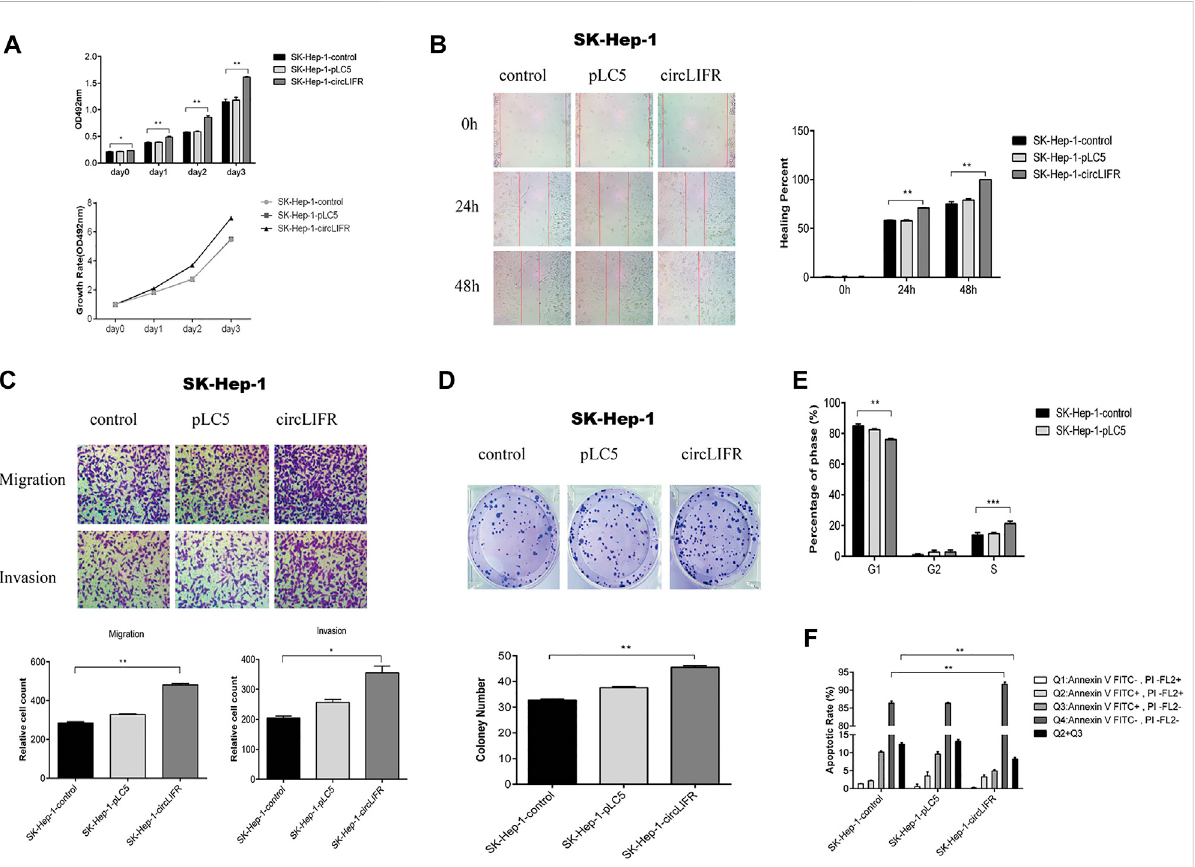
FIGURE 2 CircLIFR promotes proliferation, migration, and invasion in SK-Hep-1 cells. (A) The proliferation of SK-Hep-1 cells transfected with control overexpressioncircLIFRdetected byCCK-8 assays; (B) Wound-healing assay for migration ability ofSK-Hep-1 cells after overexpression of circLIFR; Original magni fi cation: ×10. ** p < 0.01 (C) Transwell assay shows that the overexpression circLIFR promoted metastasis and invasion of SK-Hep- 1cells.Originalmagni fi cation:×10.* p < 0.05;** p < 0.01; (D)